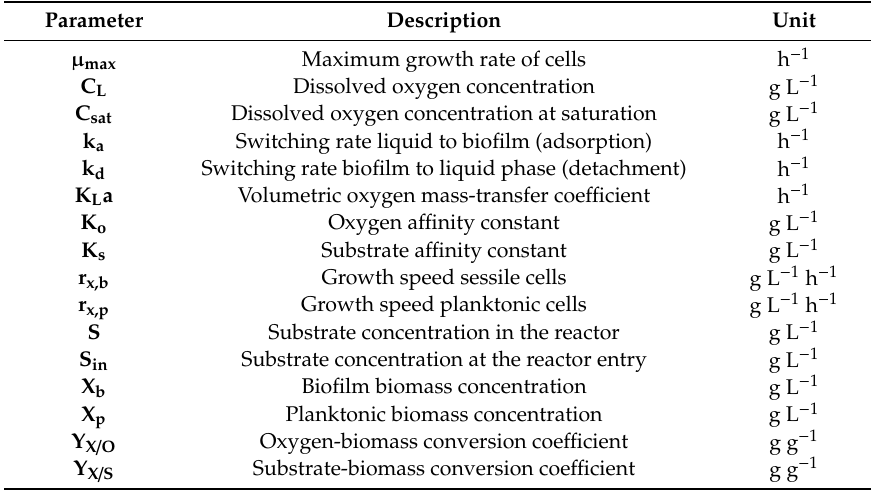
Table 2. List of parameters used for the model